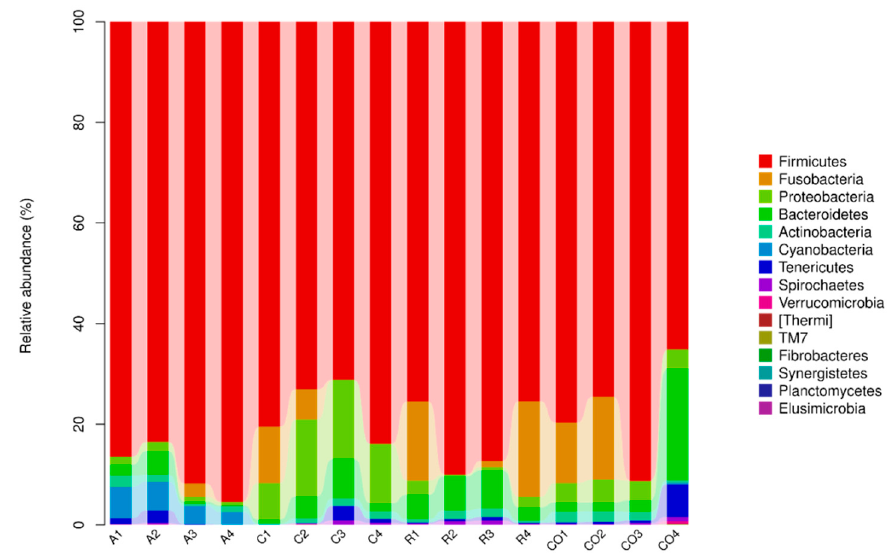
Figure 5. Bacterial community taxonomic composition and abundance at the phylum level. (A: alfalfa, C: cornstalk, R: rice straw, CO: control).